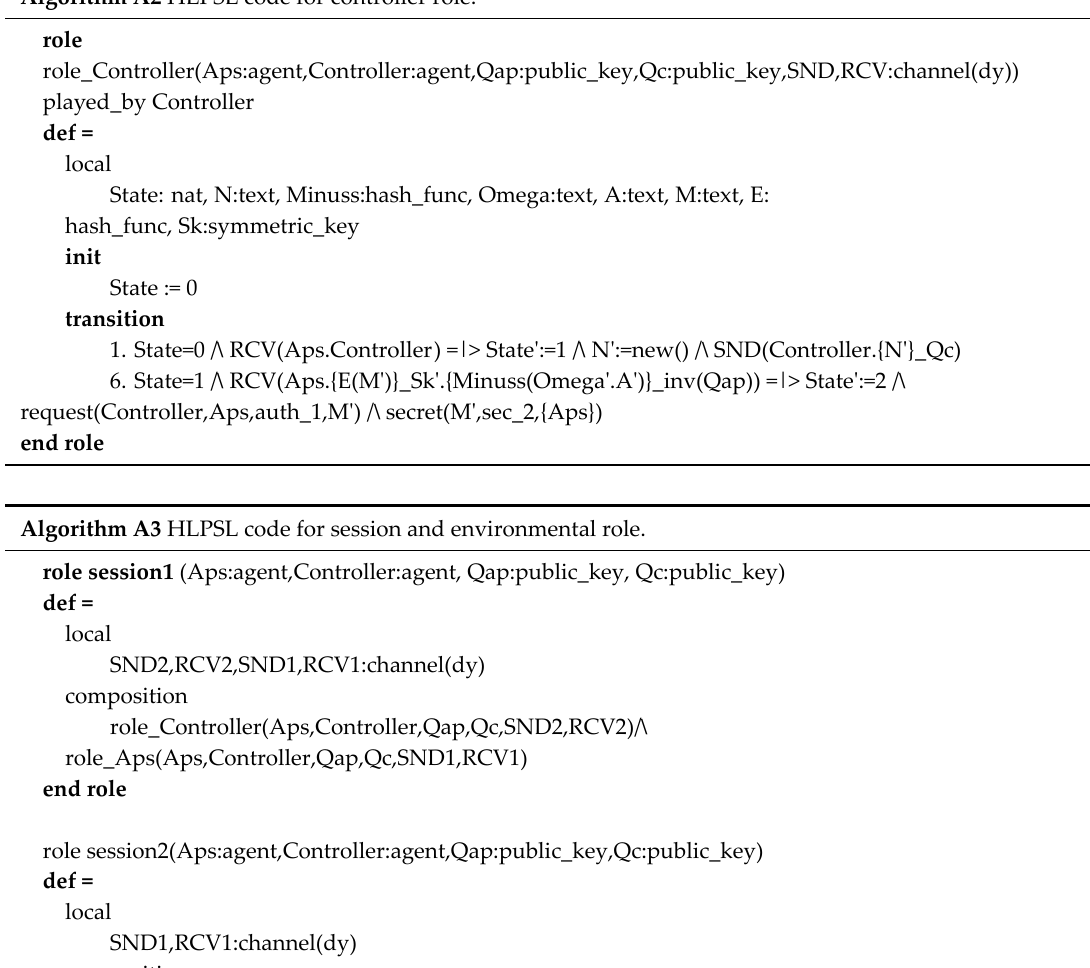
Algorithm A2 HLPSL code for controller role.